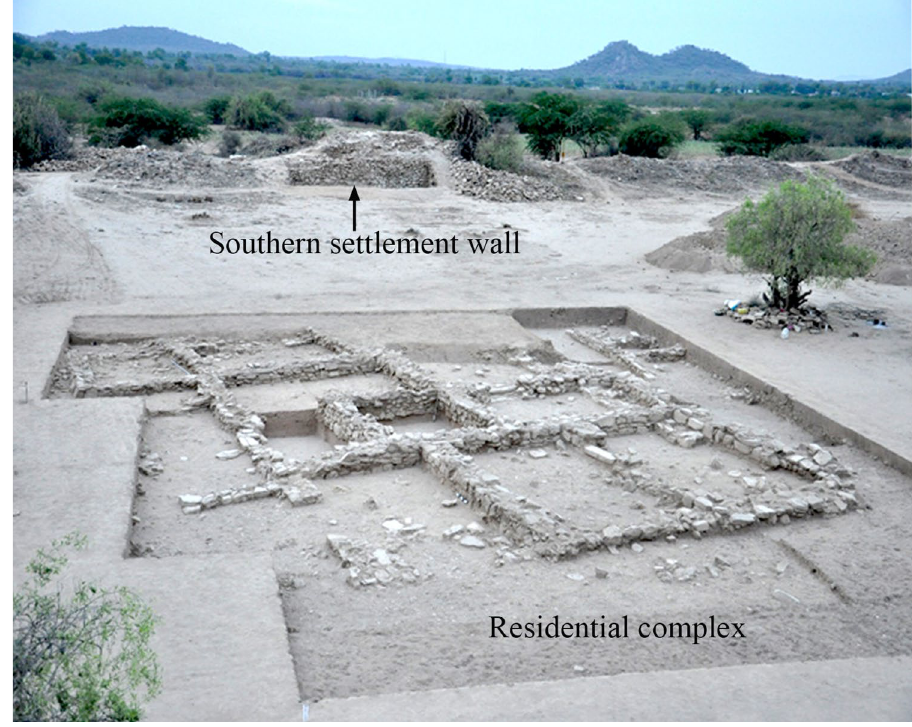
Figure 2. Excavated area of Kotada Bhadli, showing the southern settlement wall and the central residential complex with ten interconnected rooms. Picture was taken during the excavation by one of the